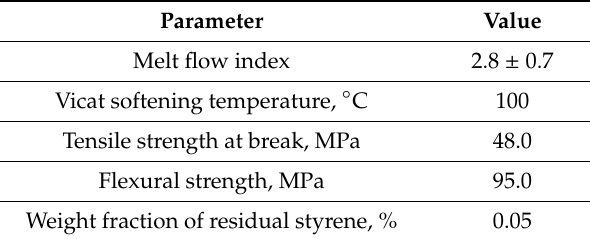
Table 1. Characteristics of 585 polystyrene.